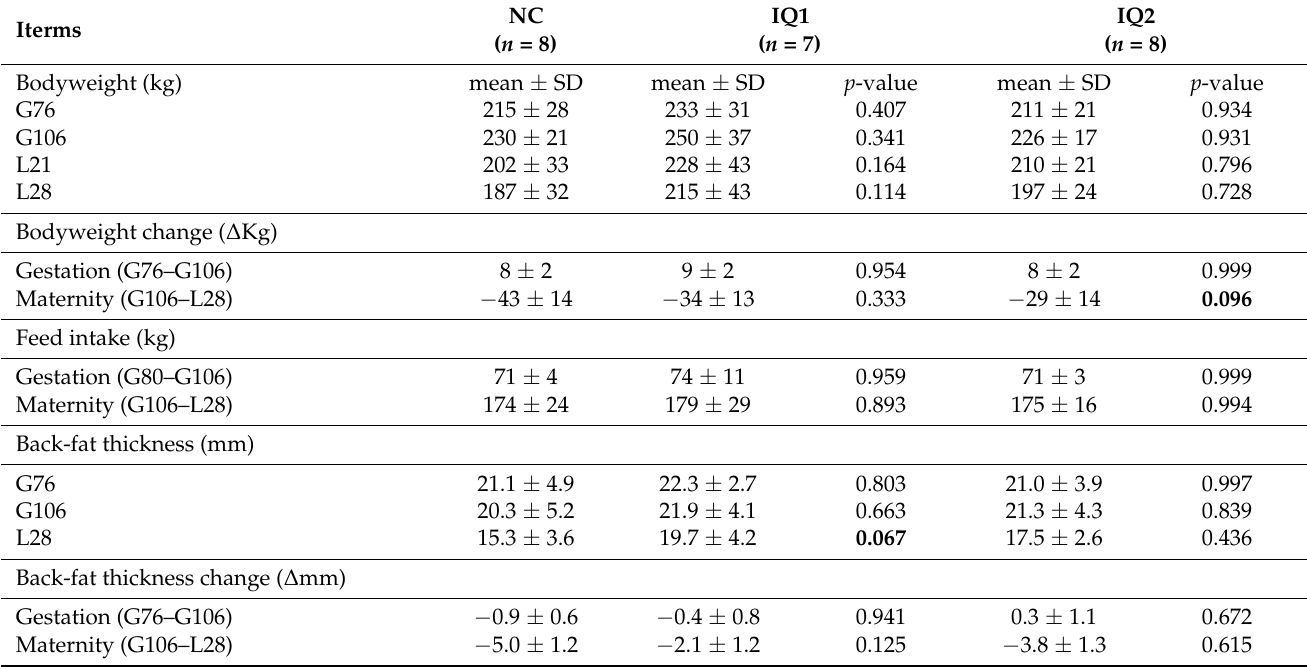
Table 3. Sows’ performance data (mean ± SD). Initial body weight, bodyweight change, feed intake, back-fat and back-muscle thickness were measured at the indicated days of experiments during the gestation period (G) and during lactation (L).